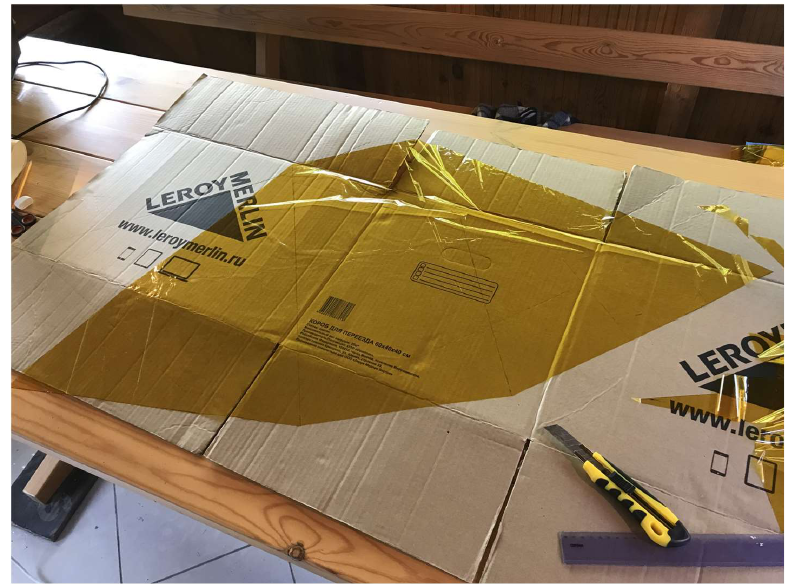
Figure 11. Kapton parawing initial planform.